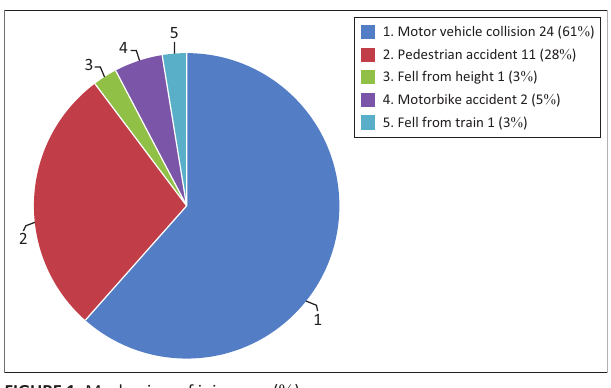
FIG URE 1: Mechanism of injury – n ( % ). TABLE 2: Analysis of computed tomography findings in vascular